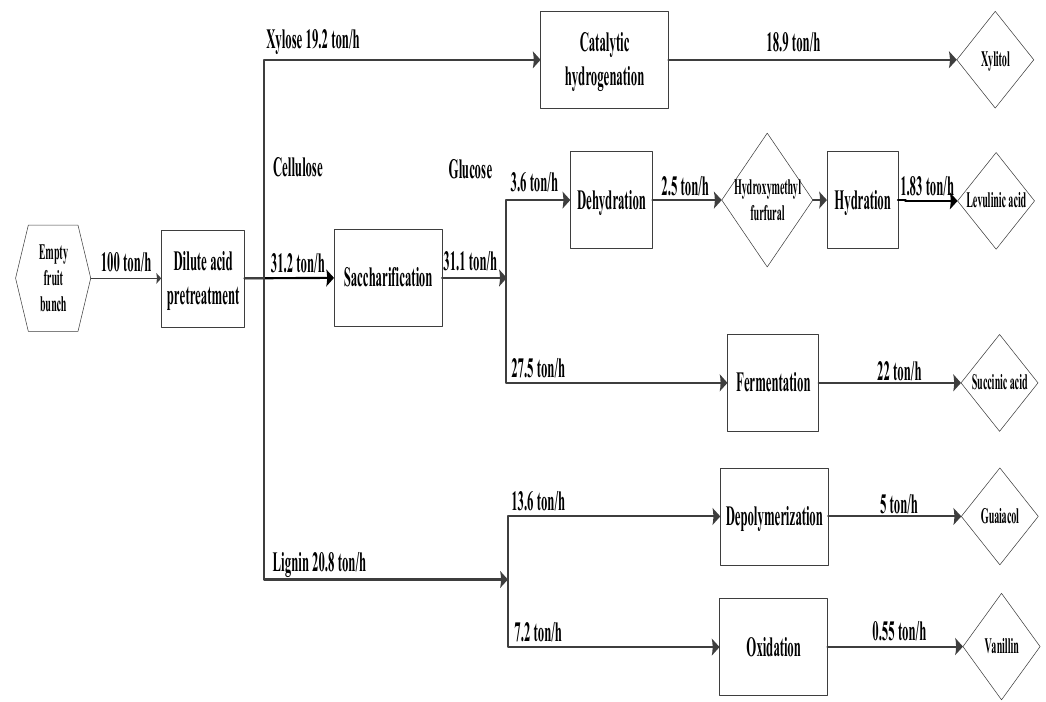
Figure 14. The optimal biorefinery configuration for simultaneously maximizing annual profit and minimizing global warming potential, fire explosion damage index, and toxicity damage index.